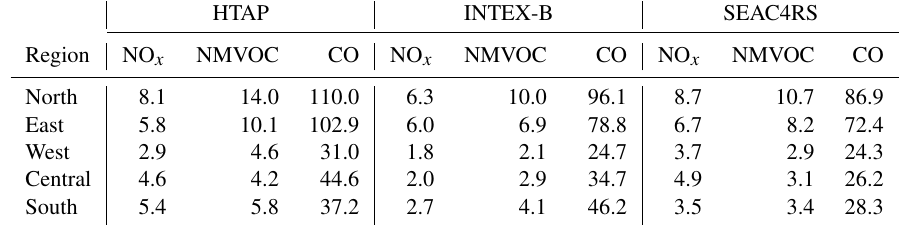
Table 2. Subregional estimates of anthropogenic emissions (in millionmolh − 1 ) in the three emission inventories used.